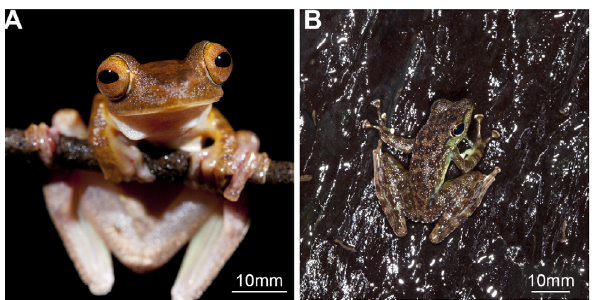
Figure 1. Frog species used in this study. Males of the (A) Harlequin Tree Frog ( R. pardalis ) and (B) the Black-spotted Rock Frog ( S. guttatus ) in their natural habitats.